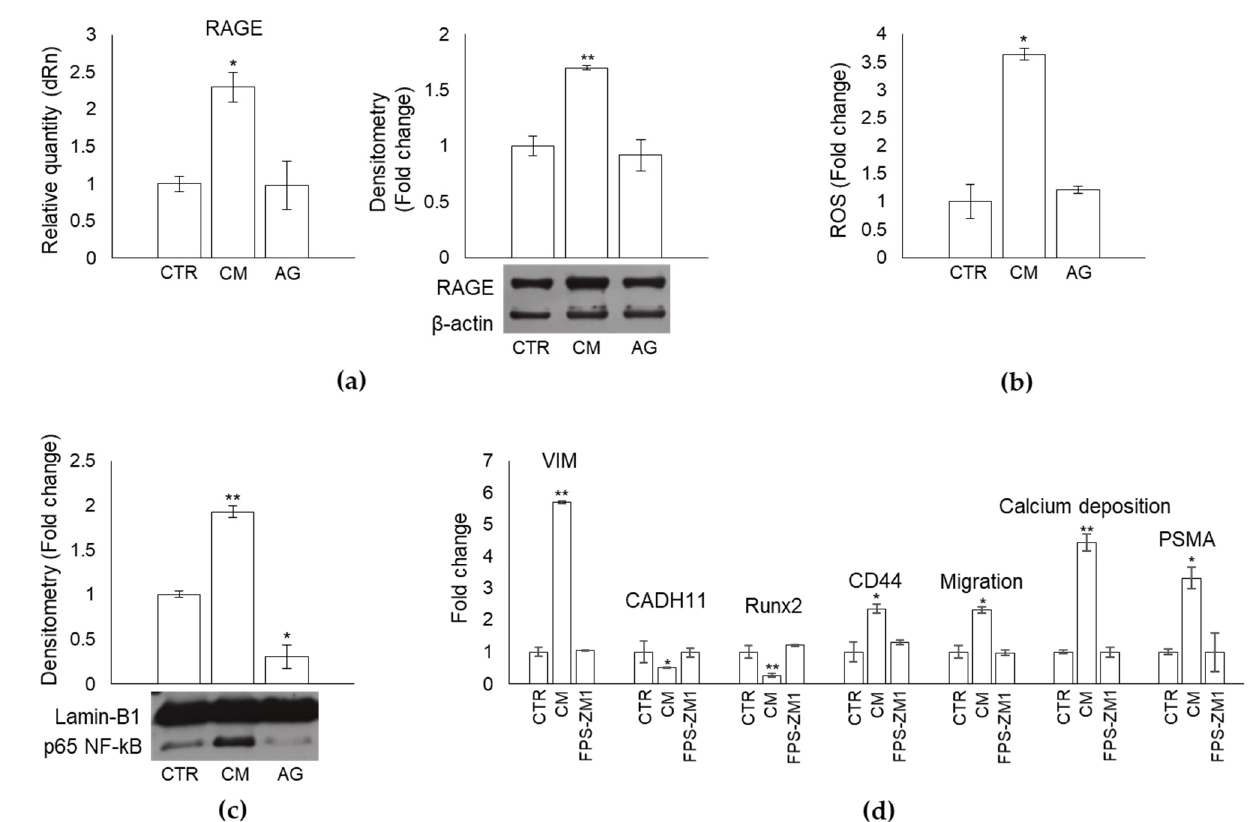
Figure 11. Methylglyoxal (MG)-derived 5-hydro-5-methylimidazolone (MG-H1) released by bone metastasis-derived PC3 cells reprograms human osteoblasts (OB) into a mesenchymal- malignant-like phenotype through a receptor for advanced glycation end products (RAGE)-dependent mechanism with the involvement of reactive oxidative species (ROS) and NF-kB signaling. ( a ) expression of RAGE, measured by real-time PCR and western blot; ( b ) intracellular levels of ROS, evaluated by 2’,7’-dichlorodihydrofluorescein diacetate; ( c ) p65 NF-kB nuclear expression by western blot and ( d ) trans-differentiation, migration, and mineralization-related responses in not exposed OB (CTR) or OB exposed for 24 h to conditioned medium (CM) from PC3 cells or to CM from PC3 pre-treated (6 h) with the specific MG scavenger aminoguanidine (AG) (1 mM) or to PC3 CM in the presence of the RAGE antagonist FPS-ZM1. Control cells (CTR) represent OB cultured for the same period of time in their specific growth medium. The histogram indicates the mean ± SD of three different cultures, and each was tested in duplicate. * p < 0.05, ** p < 0.01 versus CTR. VIM, vimentin; CADH11, cadherin 11; Runx2, runt-related transcription factor 2 ; CD44, cluster of differentiation protein 44; PSMA, prostate-specific membrane antigen.